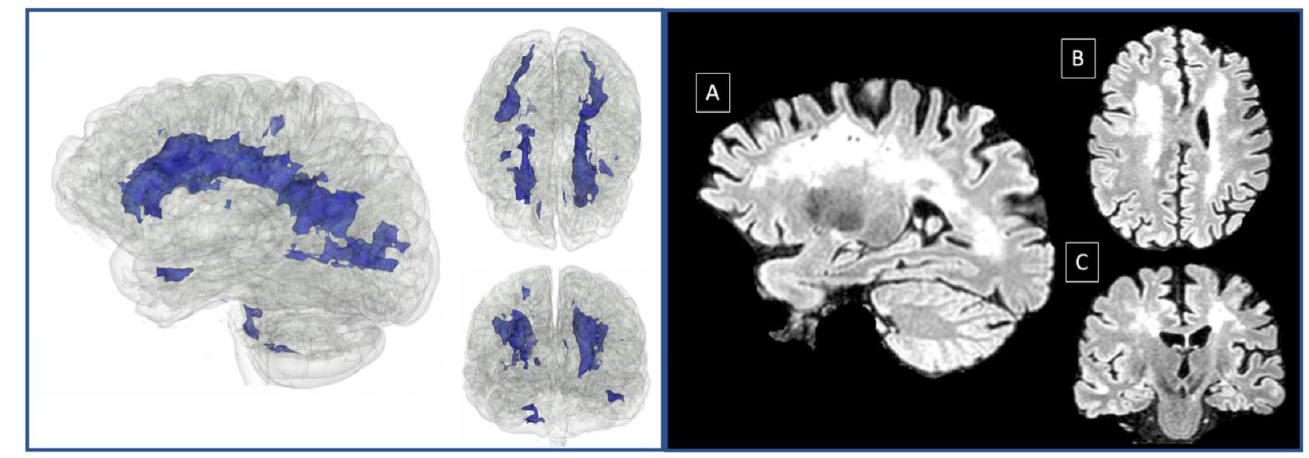
Figure 3. White matter lesions 3D model in native space (left). Saggital ( A ), axial ( B ) and coronal ( C ) view of 3D Flair in native space (right). The three- dimensional (3D) brain model was built from a patient’s (P6) 3D Flair (Repetition time (TR): 4800 ms, Echo Time (|TE): 284 msec, slice thickness 1.48mm, flip angle: 90, sagittal orientation) in native space, using the Model Maker Module, in 3D slicer version 4.11.2 [56]. White matter lesions were automatically detected with 3D Flair as input, using Lesion Spotlight extension [57,58] run on 3D slicer.